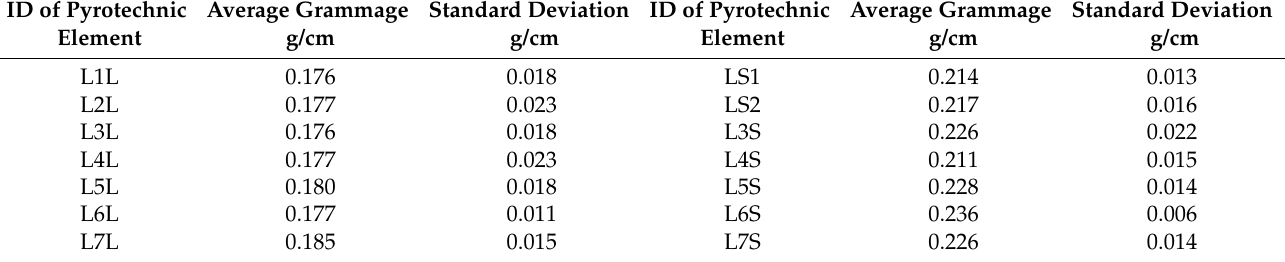
Table 3. Grammage measurement.